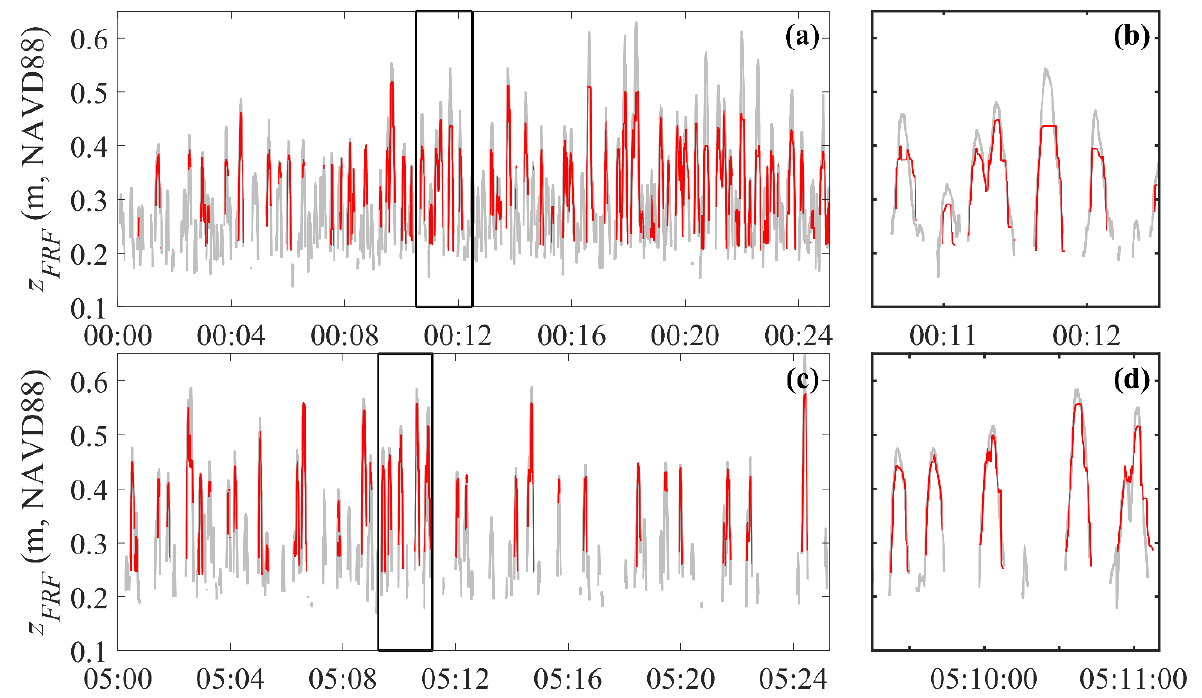
Figure 11. Elevation of wave runup, R z , measured by the LLC LiDAR (red) and the FRF DUNE LiDAR (white) for two 25-min spans during Series C (18 November 2020): ( a , b ) rising tide, and ( c , d ) falling tide. The thick black boxes in ( a , c ) define the time spans expanded in ( b , d ). Times in UTC.